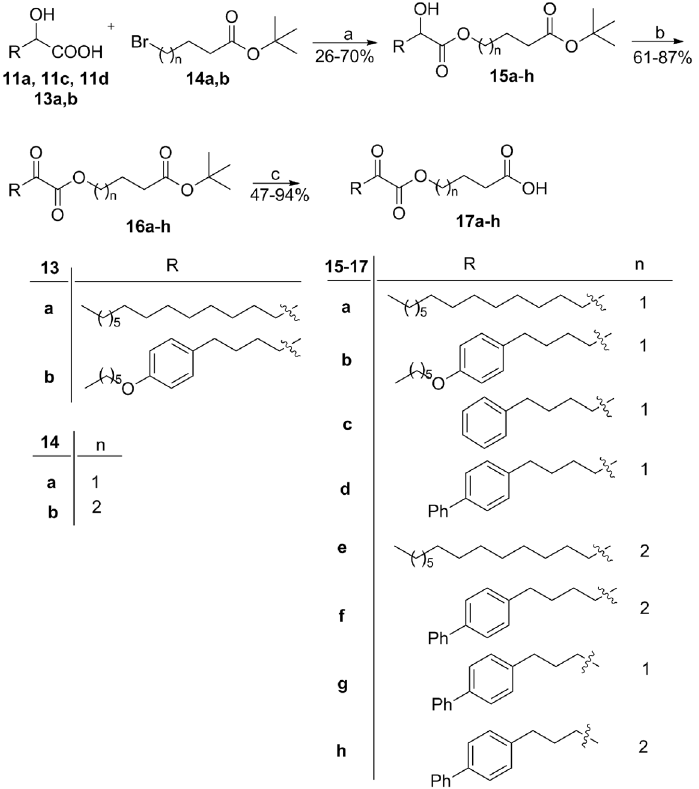
Figure 4. Synthesis of 2-oxoesters. ( a ) i. 20% aq. sol. Cs 2 CO 3 , THF, H 2 O, ii. Br(CH 2 ) n CH 2 CH 2 COOBu t , DMF, reflux overnight; ( b ) Dess-Martin periodinane reagent, dry CH 2 Cl 2 ; ( c ) 50% CF 3 COOH in CH 2 Cl 2 .